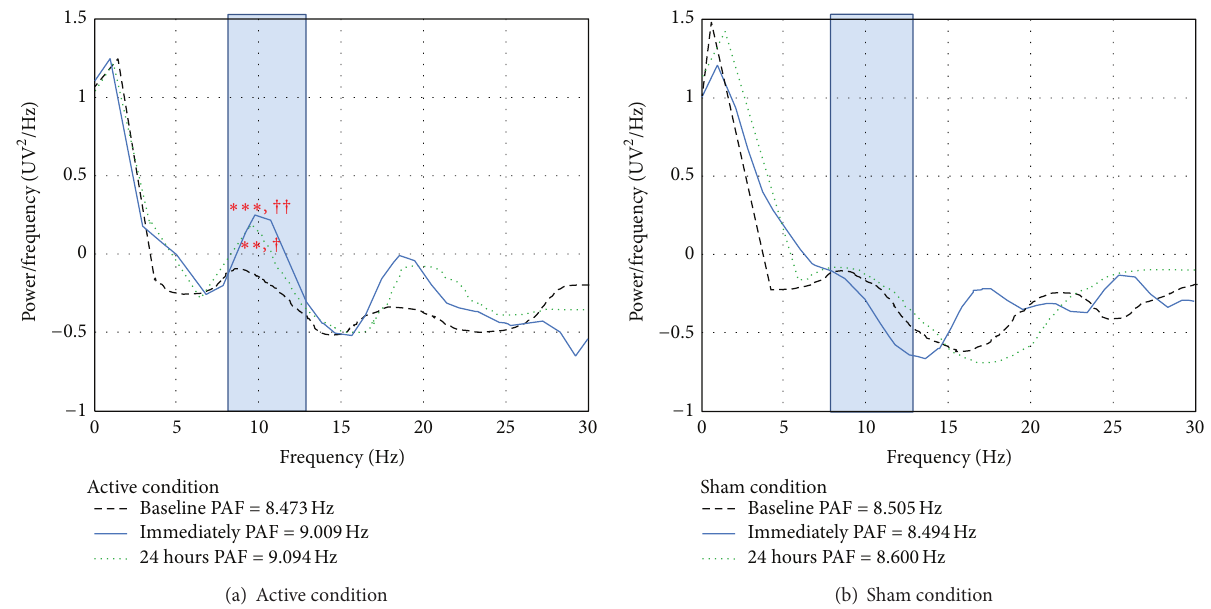
Figure 2: Power spectrum density at baseline relative to immediately after stimulation and 24 hours after stimulation for the two treatment conditions. (a) In the active condition, the results show significant increases in peak alpha frequency (PAF) between baseline (black dashed line) and immediately after stimulation (blue line) ( 𝑃 < 0.001 ). Significant increases in PAF from baseline were also found at 24 hours after stimulation( 𝑃 = 0.004 ).(b)Intheshamcondition,nosignificantchangesinPAFwerefoundateitherassessmentpoint.Significantdifferences following active treatment, relative to baseline, are indicated by ∗∗ 𝑃 < 0.01 ; ∗∗∗ 𝑃 < 0.001 . Significant differences following sham treatment, relative to baseline, are indicated by † 𝑃 < 0.05 ; †† 𝑃 < 0.01